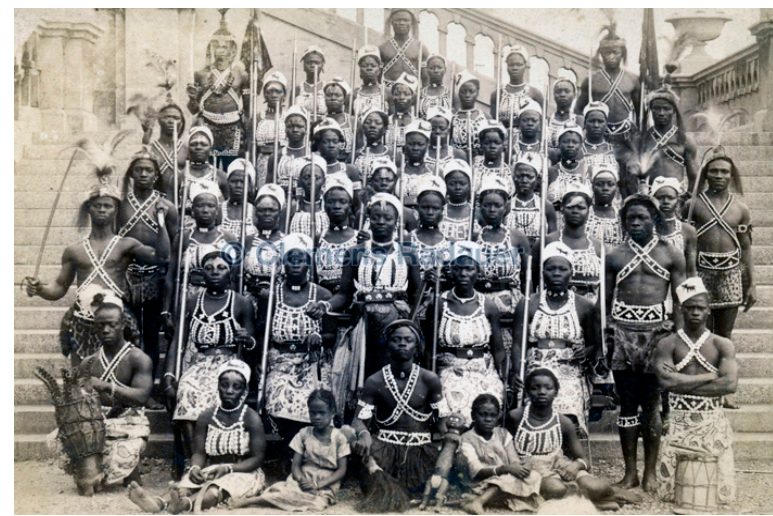
Figure 18. A postcard from the Crystal Palace in London in 1893 showcasing women warriors from the Kingdom of Dahomey. Public Domain.